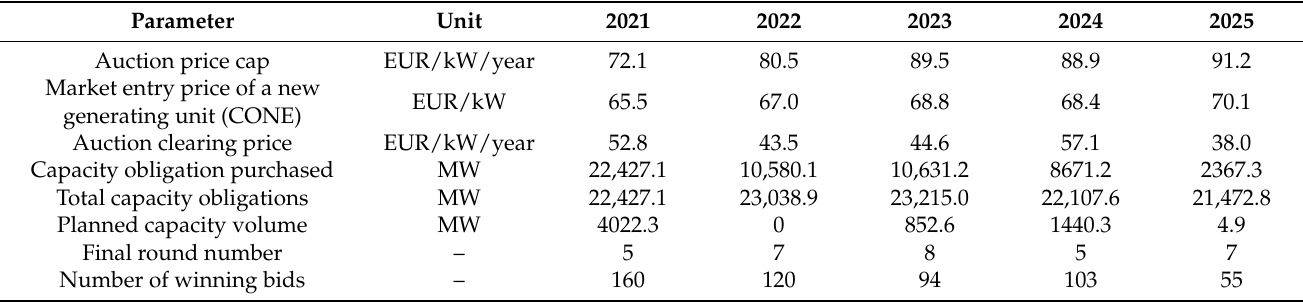
Table 1. Final results of the main capacity auction for 2021–2025 delivery years.